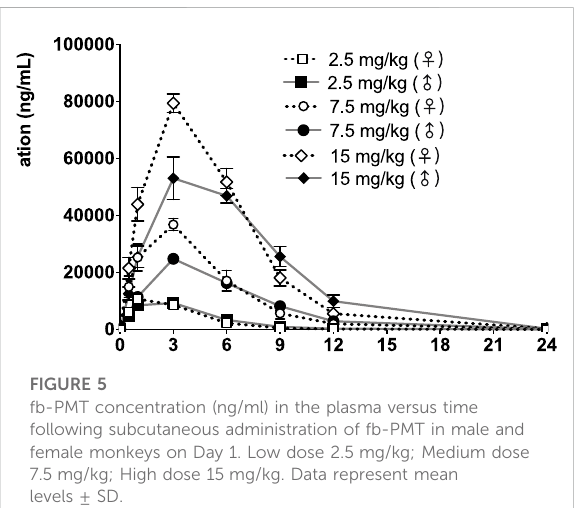
FIGURE 5 fb-PMT concentration (ng/ml) in the plasma versus time following subcutaneous administration of fb-PMT in male and female monkeys on Day 1. Low dose 2.5 mg/kg; Medium dose 7.5 mg/kg; High dose 15 mg/kg. Data represent mean levels ± SD.